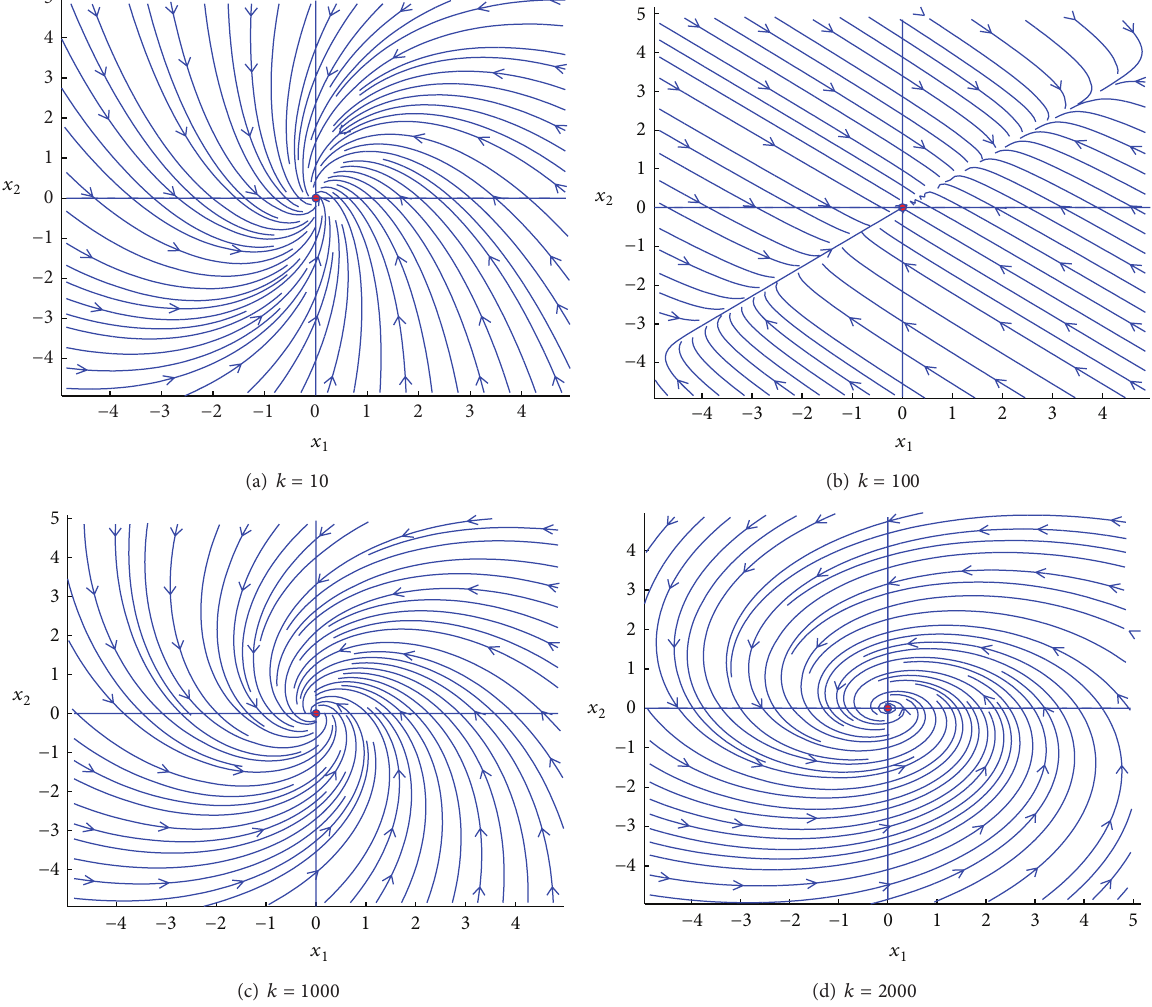
Figure 2: Phase portrait and switching surfaces with 10, 100, 1000, and 2000